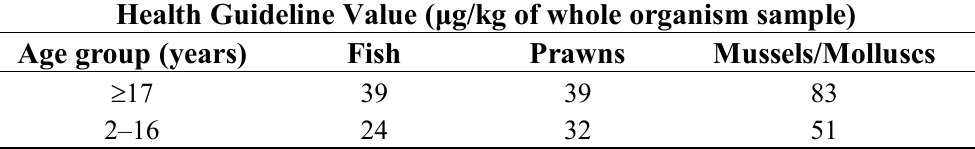
Table 5. Derived health guideline values for microcystins in